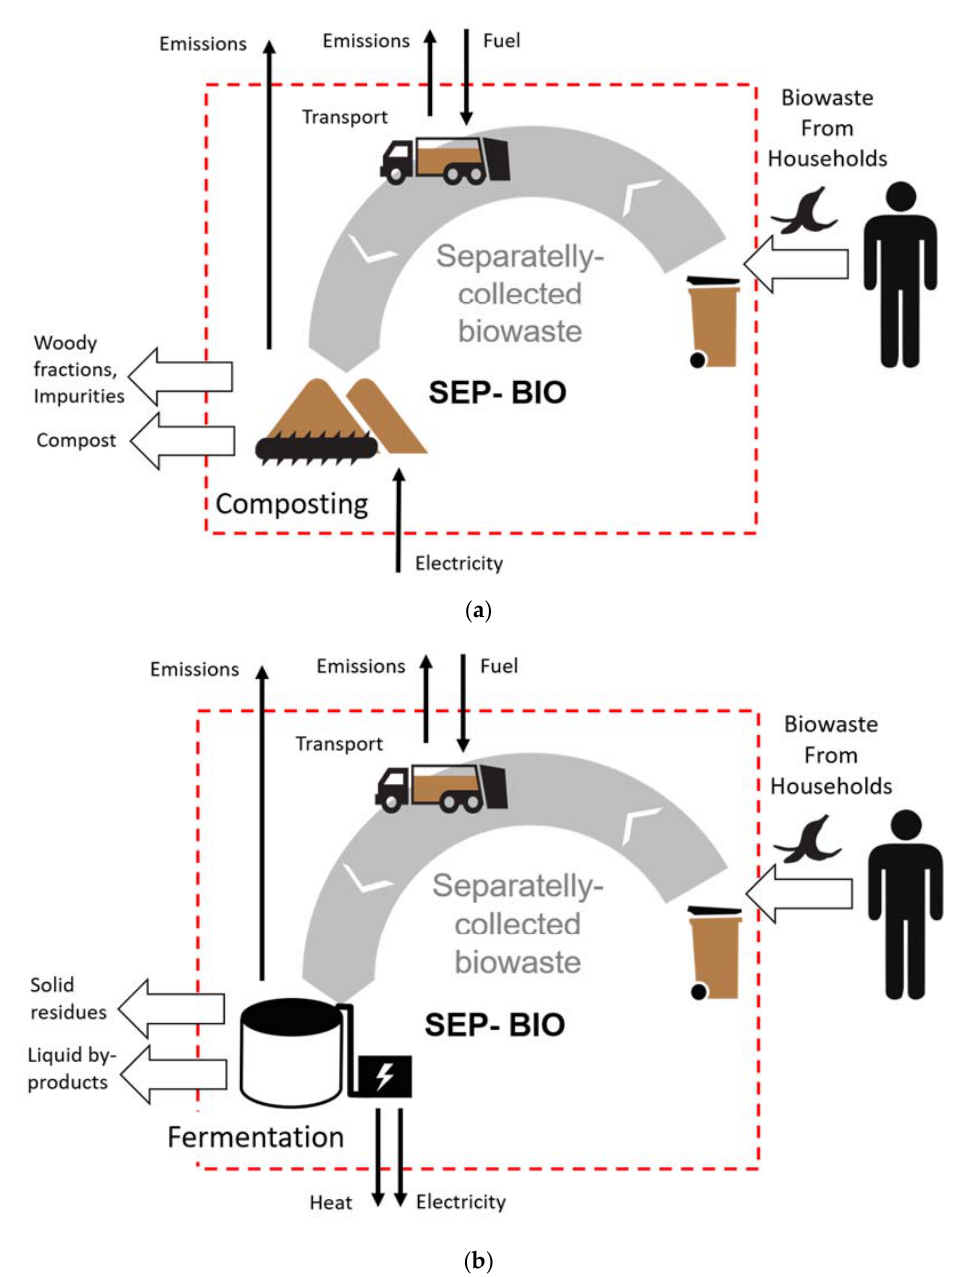
Figure 2. System boundaries for separately collected biowaste (SEP ‐ BIO) treatment routes: ( a ) composting; ( b )